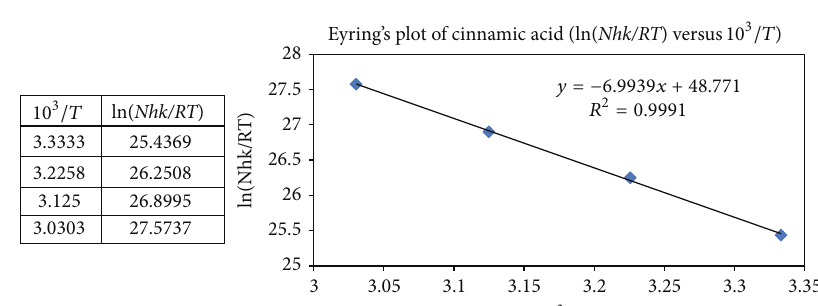
a considerable variation in the enthalpies and entropies of activation is more likely. The entropy of activation ( Δ𝑆 #